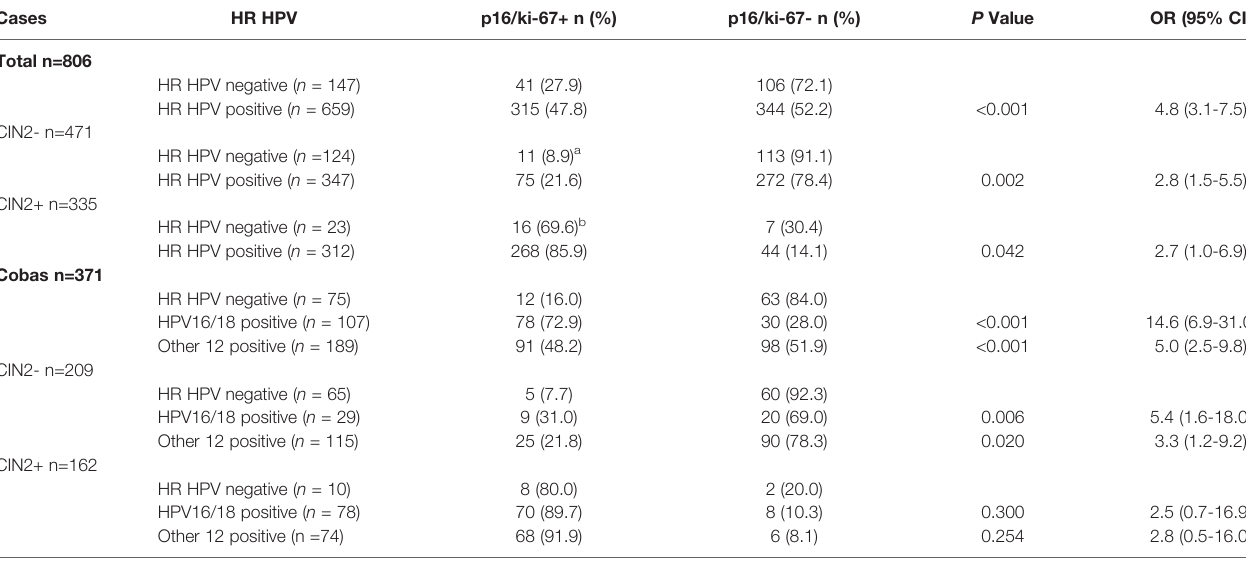
TABLE 2 | Association of p16/ki-67 dual-staining with HR HPV infection and HR HPV genotypes in histology category.